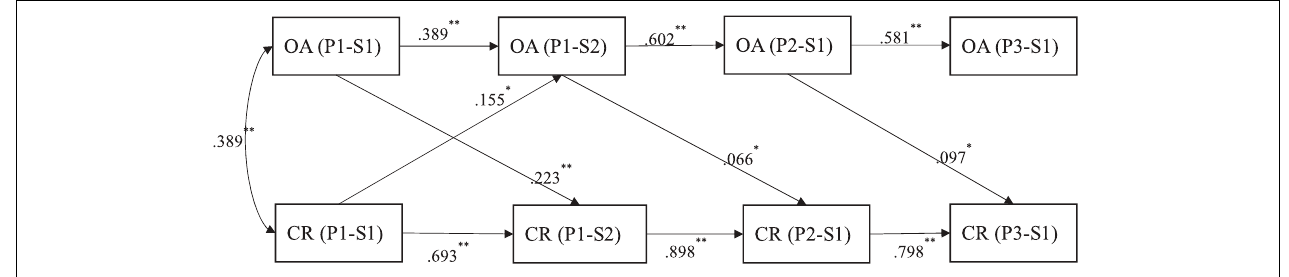
FIGURE 2 | The relationship between orthographic awareness and character reading from P1 to P3. Standardized coefficients are reported. All non-significant paths were not shown for the simplicity of presentation. OA = orthographic awareness, CR = character reading. ∗ p < 0.05, ∗∗ p <